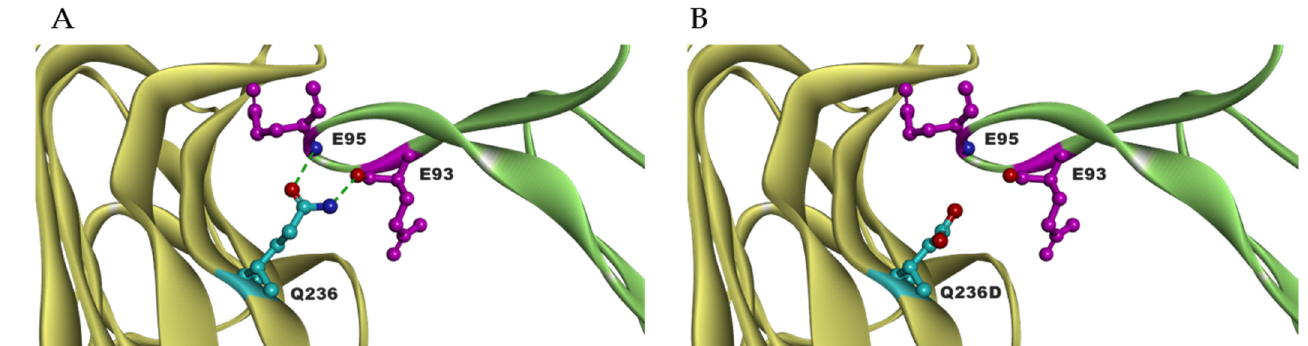
Figure 4. Predicted area of interaction of RANKL and OPG receptor (PDB:4E4D) around position 236. ( A ) OPG (green) binds to RANKL WT (yellow); ( B ) OPG (green) binds to RANKL Q236D (yellow).